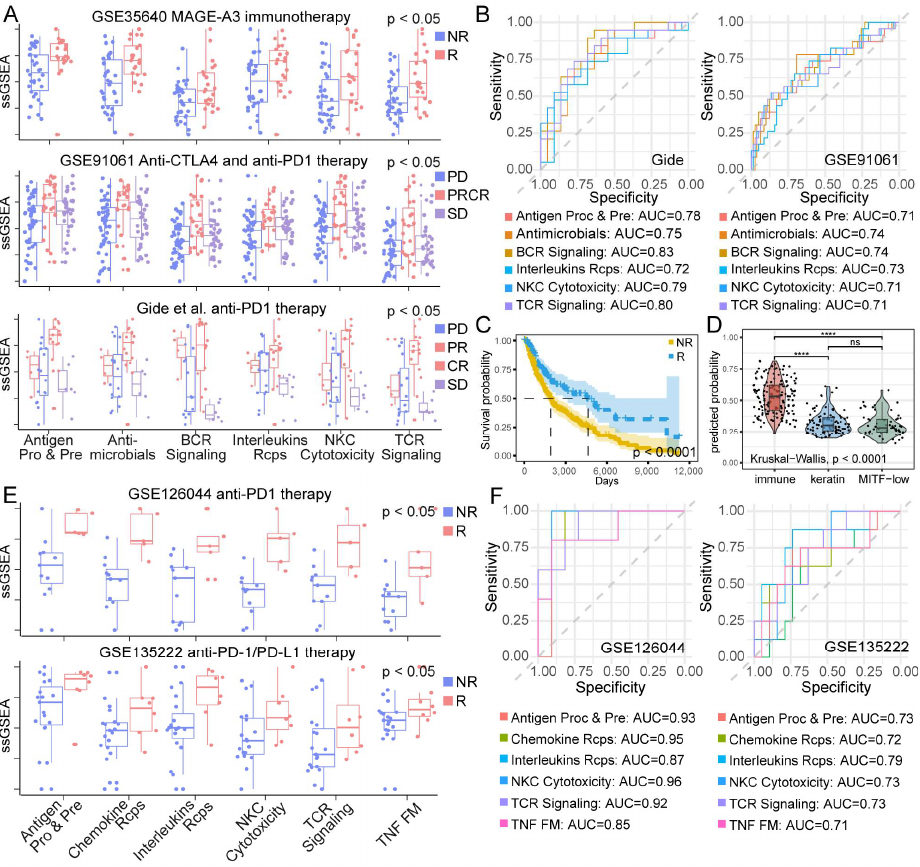
Figure 6. IRP scores were associated with patient response to immunotherapy. ( A ) Comparison of IRP expression level in melanoma patients between responders and non-responders. ( B ) ROC curves of 6 IRPs in 2cohorts of melanoma patients. ( C ) KM curve between predicted responder and non-responder in TCGA SKCM dataset. ( D ) Predicted possibility to be ICB the responder among three SKCM phenotype. ‘****’ denotes p < 0.0001, ‘ns’ denotes not significant. ( E ) Comparison of IRP expression level in lung cancer patients between responders and non-responders. ( F ) ROC curves of 6 IRPs in 2 cohorts of lung cancer patients.